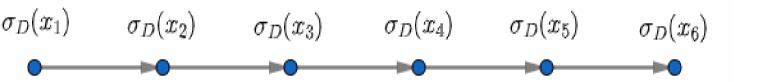
Figure 8. The minimum dominating set of P σ ) = ∑ 3 σ D ( x 2 k − 1 ) number is γ ( P σ k = 1 D